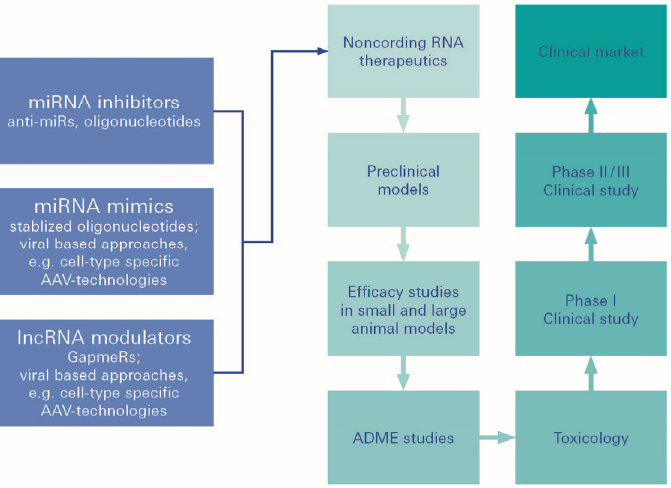
Figure 5. MiRNA therapeutics. MiRNA (miRNA) ‐ based therapeutics can be divided into miRNA mimics and miRNA inhibitors, the so ‐ called antimiRs. miRNA mimics are synthetic double ‐ stranded small RNA molecules that match the corresponding miRNA sequence, and therefore, aim to functionally replenish lacking, dysfunctional, or lost miRNA expression in diseases.